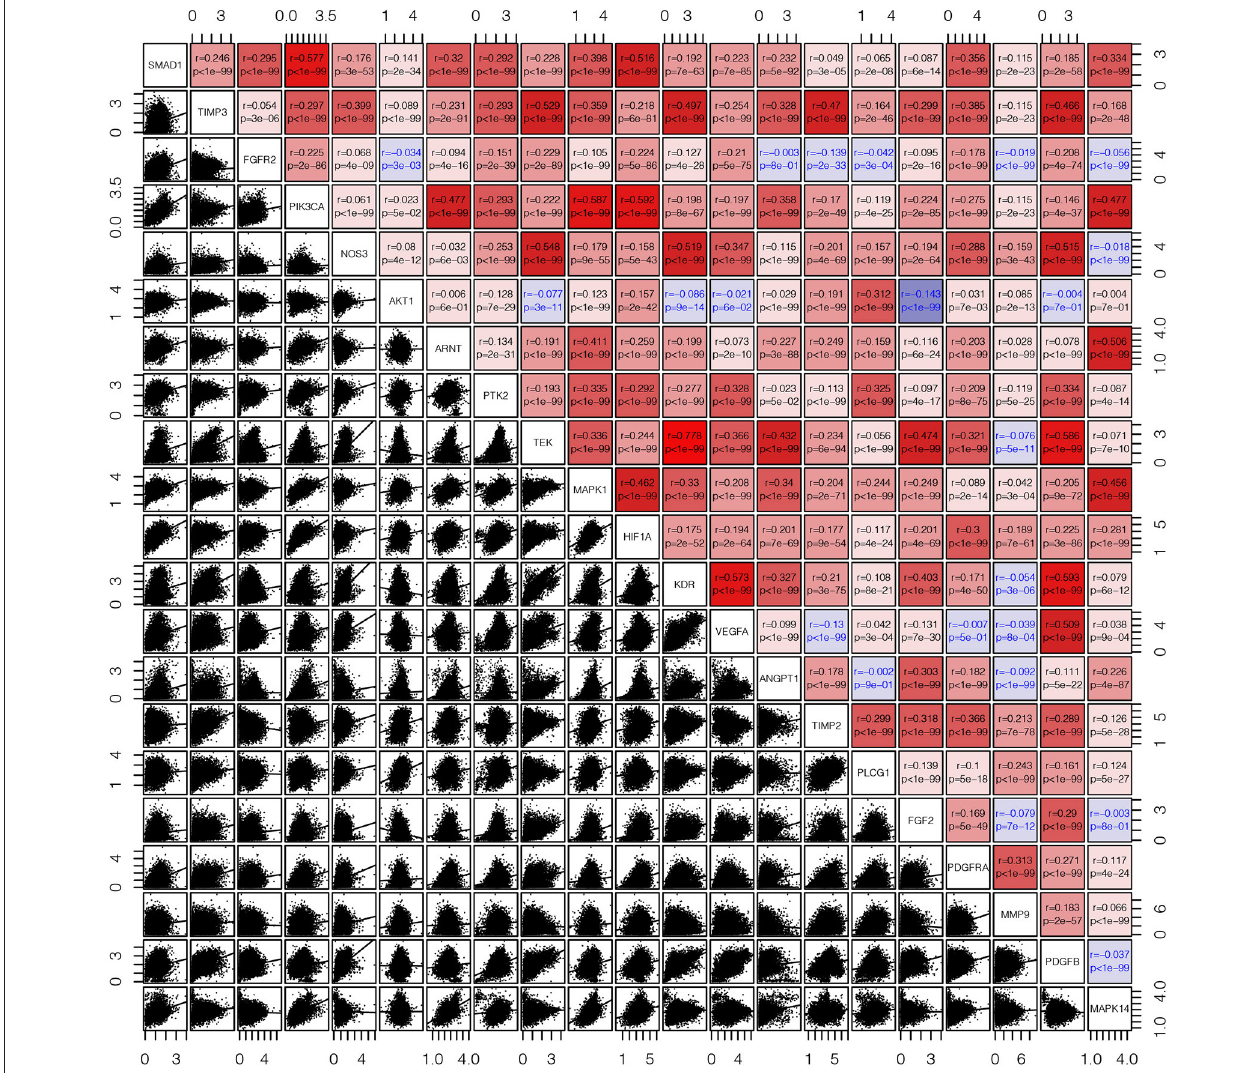
FIGURE 2 | The corrgram showed that there was a co-expression correlation between the angiogenesis pathway genes in pan-cancer. We used the “pair” function in the graphics R package to draw this picture. The gene expression data were normalized by log(1 + x). The scatter plot and regression line are drawn in the lower-left panel. The corresponding genes are displayed on the diagonal, and the Pearson’s correlation coefficient and the corresponding p -values are displayed in the upper right panel. The Pearson’s correlation coefficient is projected to five colors, negative values are displayed in blue, and positive values are displayed in